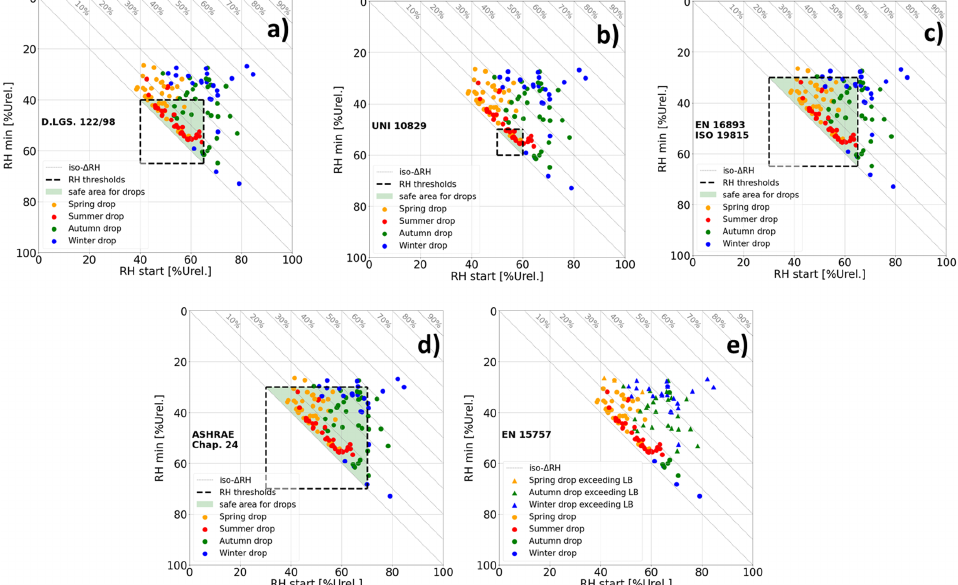
Figure 6. Scatterplots of the drops of RH identified in Ringebu church through the MoD strategy as originally explained in [20], together with the thresholds defined by the standards: D. Lgs. 122 art. 150 par. 6 ( a ), UNI 10829 ( b ), EN 16893 and ISO 19815 ( c ), ASHRAE Chap. 24 ( d ), EN 15757 ( e